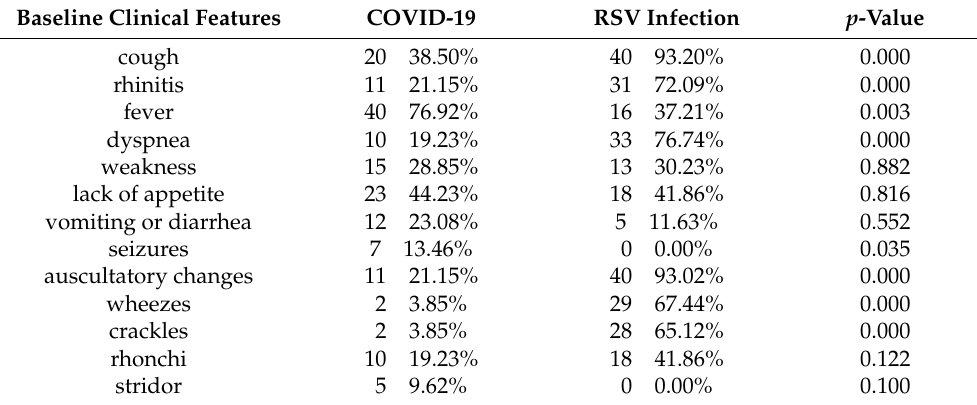
Table 1. The baseline clinical features of RSV and COVID-19 patients at hospital admission.